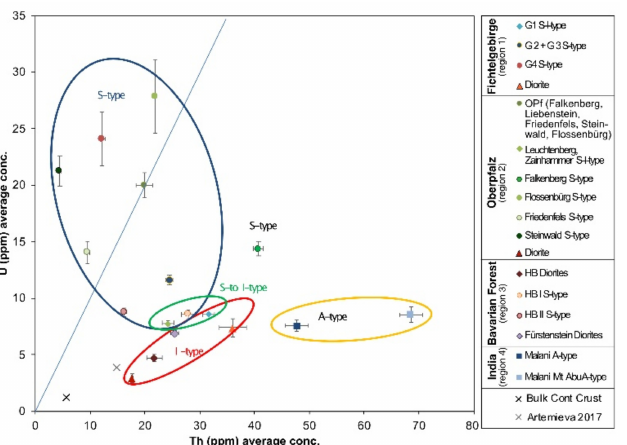
Figure 8. Average Th and U concentrations of the different granites and diorites from this study. Bulk continental crust from [2,23]. All A- and I- and I- to S-type granites fall within the field for Th/U > 1, but the S-type granites lie partly in the Th/U >1 and partly in the Th/U < 1 field. Data and statistical analysis are given in Tables S1–S3 in the Supplementary